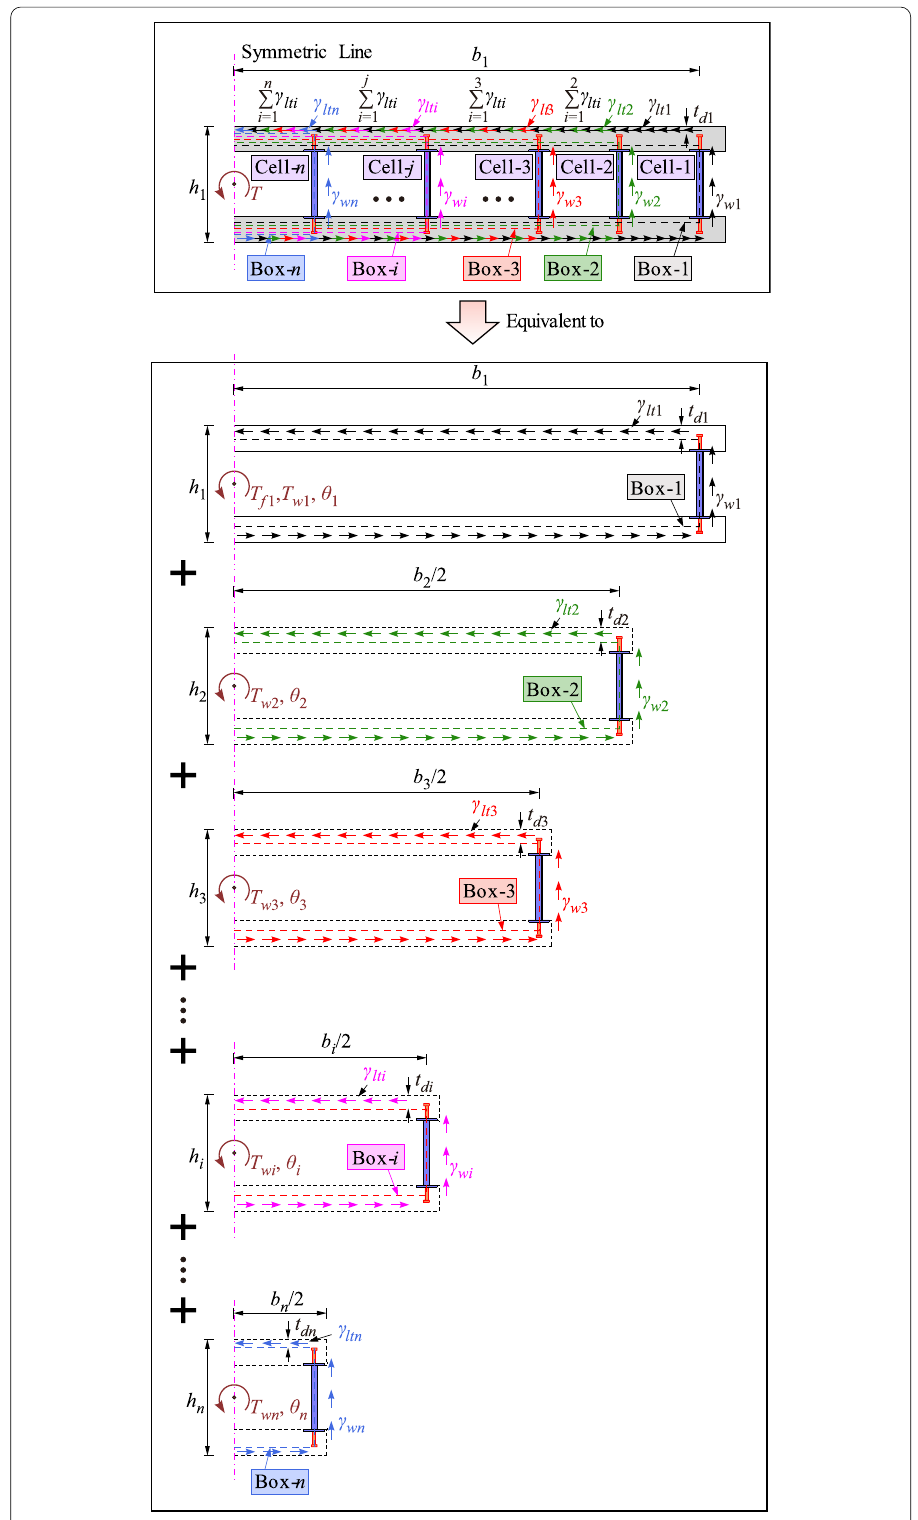
Fig. 3 The equivalence of torsion in the BGCSW with 2 n (or 2 n -1)